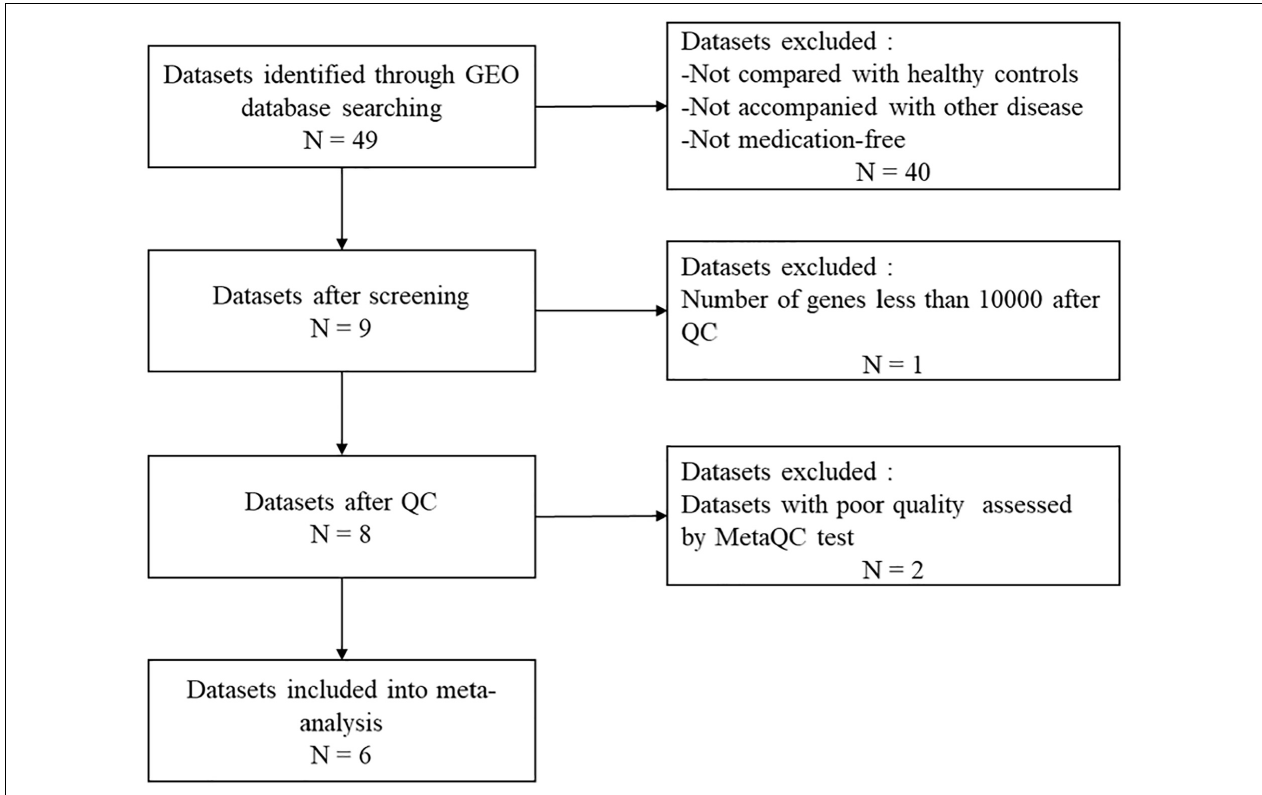
FIGURE 1 | Workflow of data processing. GEO, Gene Expression Omnibus; QC, quality control.